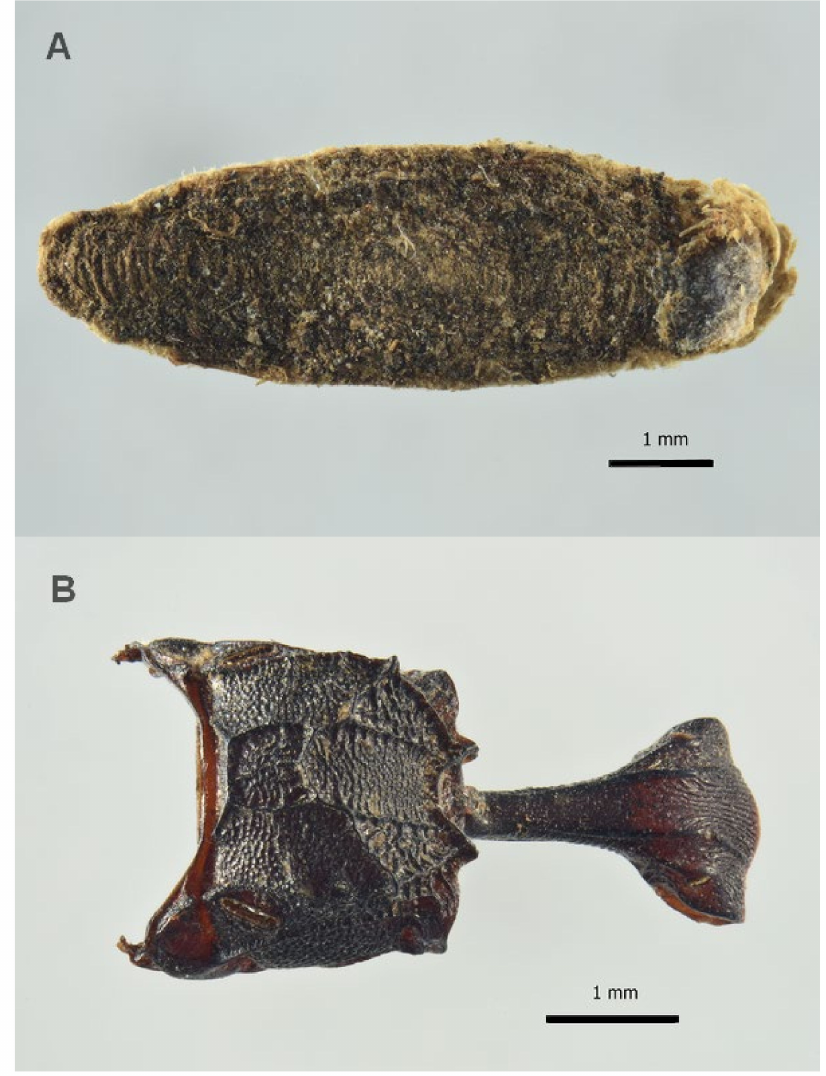
Figure 5. Lepidoptera and Hymenoptera remains associated to the burial site of Saint Davino Armeno: ( A ) Tineidae, cocoon; ( B ) Ichneumonidae,